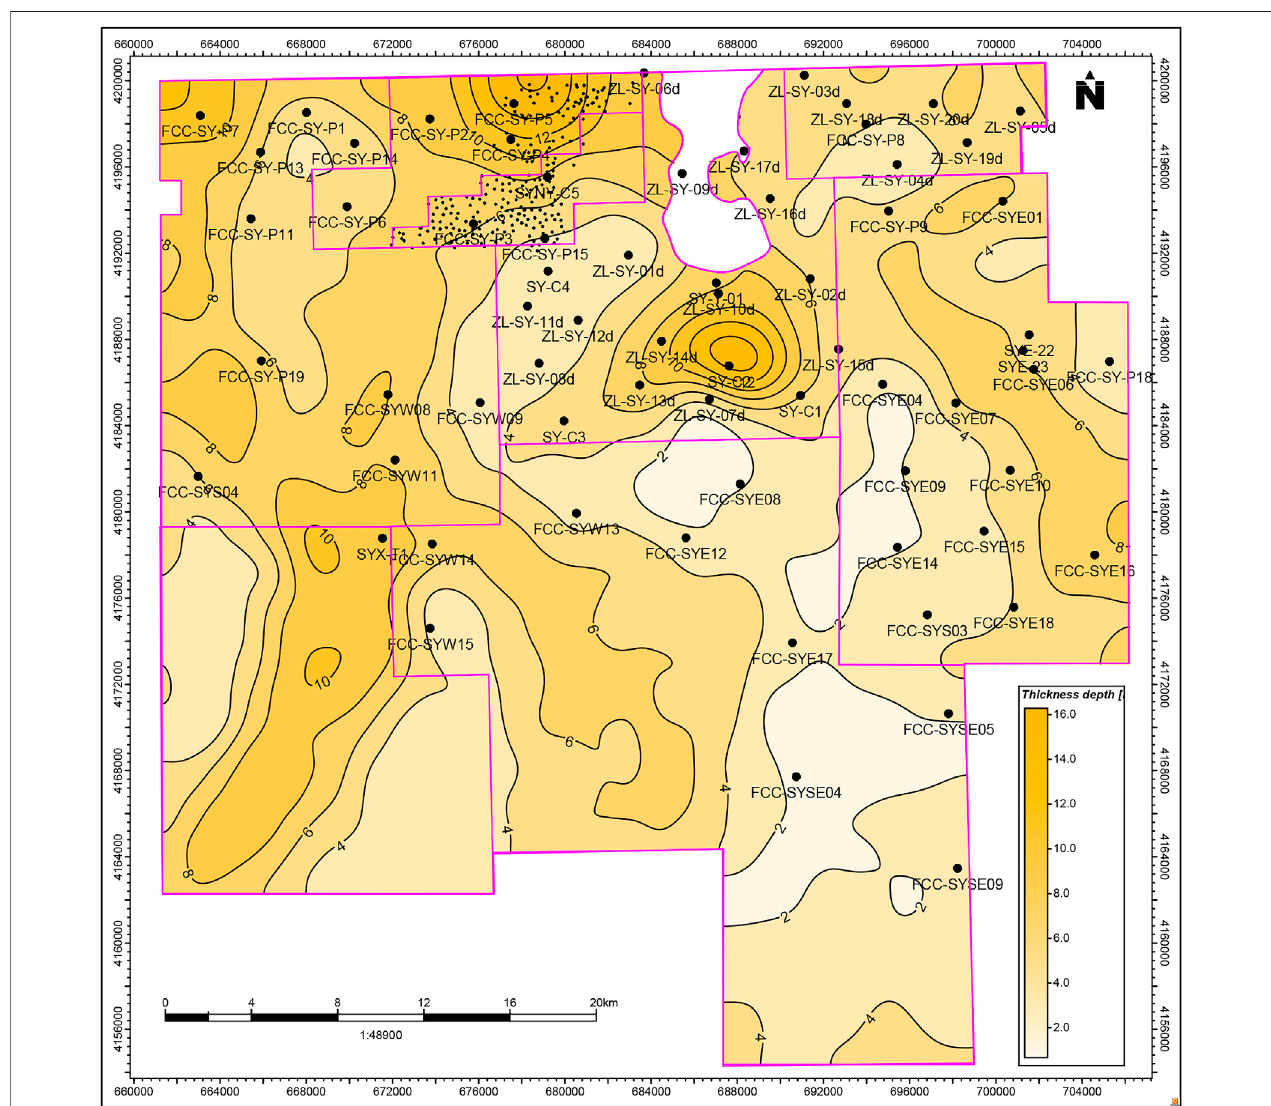
FIGURE 2 | Thickness distribution of the water-bearing sandstone layer near the upper 20 m of the top plate of the #15 coal seam.